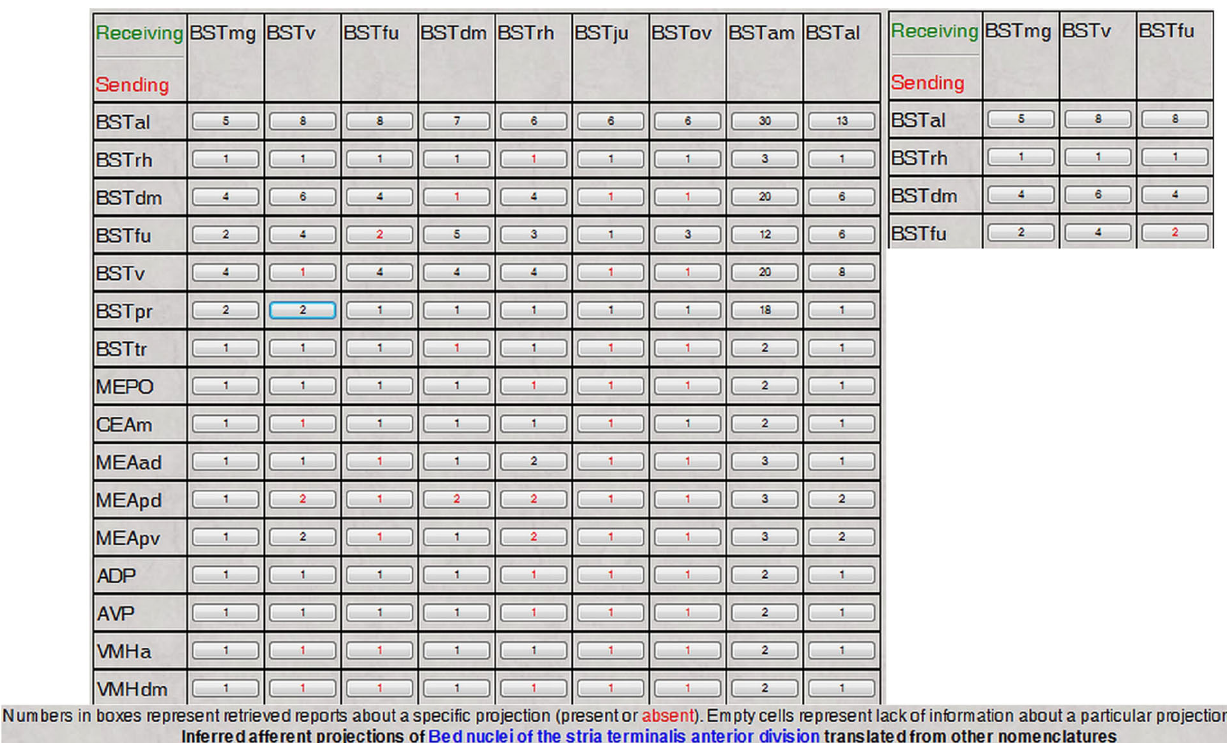
FIGURE 6 | The reconstructed and translated projections matrix of the anterior division of the rat BST, as defi ned in Swanson (2004) nomenclature. The inset shows a magnifi ed portion of the